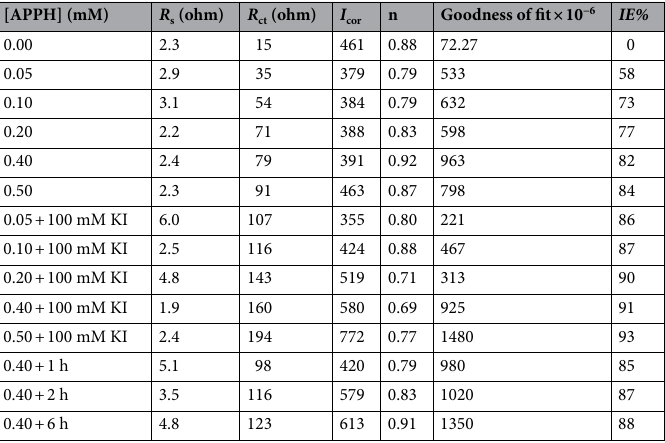
Table 3. The current comparable circuit simulation settings and associated inhibition efficiency (IE) of LCS in 0.5 M H 2 SO 4 containing different APPH concentrations at 303